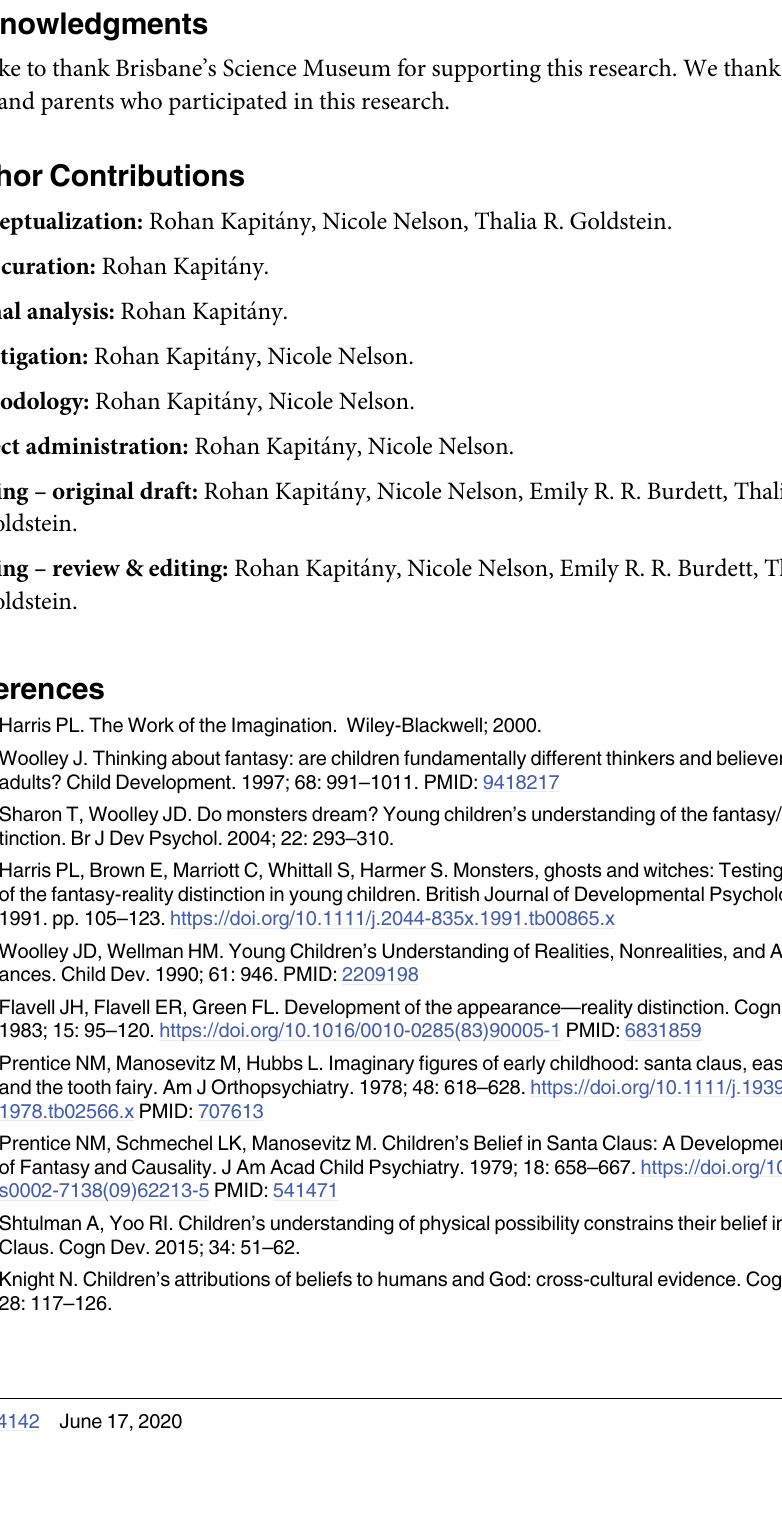
S1 Table. Responses to epistemological question for four